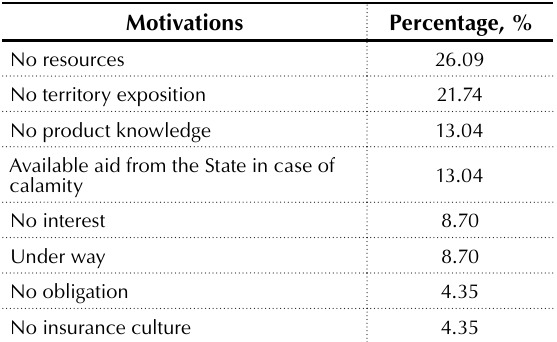
Table 2. Motivations behind